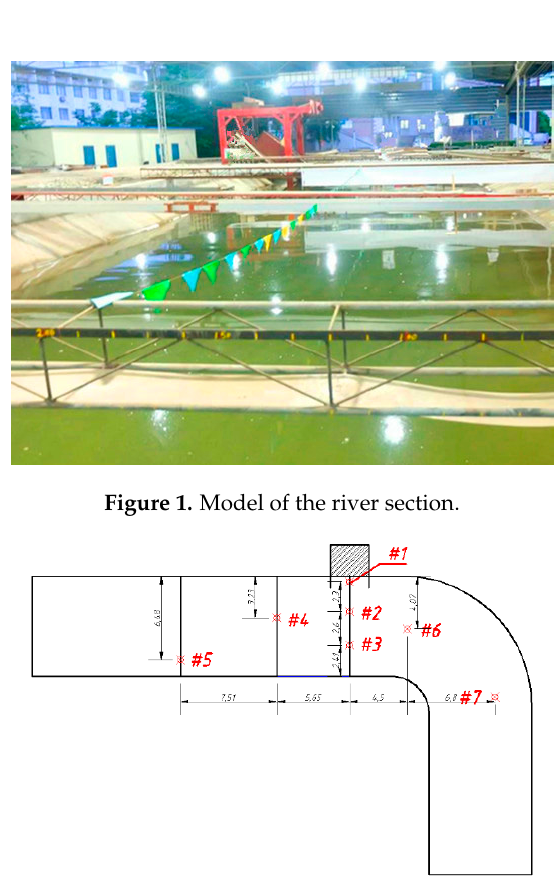
Figure 2. Model of the generalized plan.